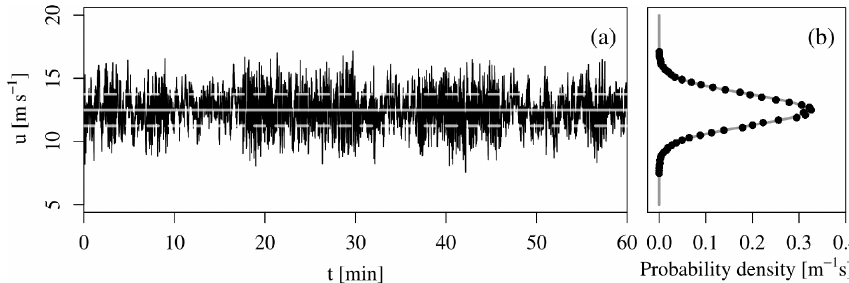
Figure 2. Exemplary intermittent wind time series. The figure is analogous to Fig.